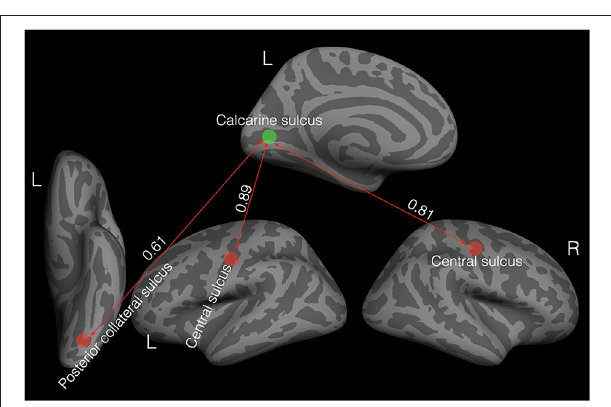
FIGURE 2 | Elevated covariation in cortical thickness in the patients ( N = 11). The green disc indicates the seed area: the left Calcarine sulcus. The red discs represent areas with positive correlations in cortical thickness with the seed area. All the correlation values are significantly different from zero and significantly higher than the corresponding correlation values in the controls based on bootstrapped 99% confidence